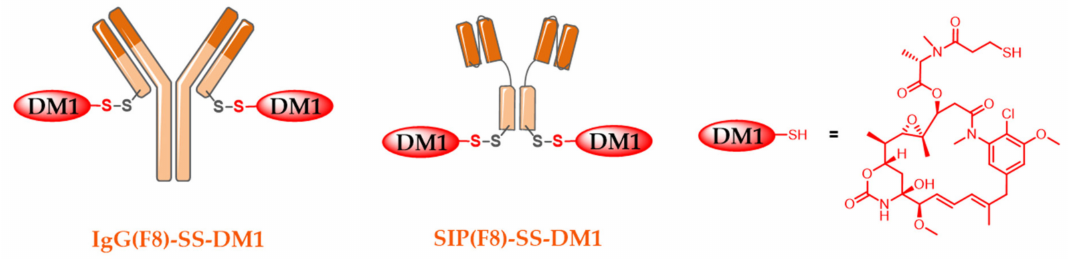
Figure 7. Immunoconjugates IgG(F8)-SS-DM1 and SIP(F8)-SS-DM1 with a DAR 2, and formula of the payload